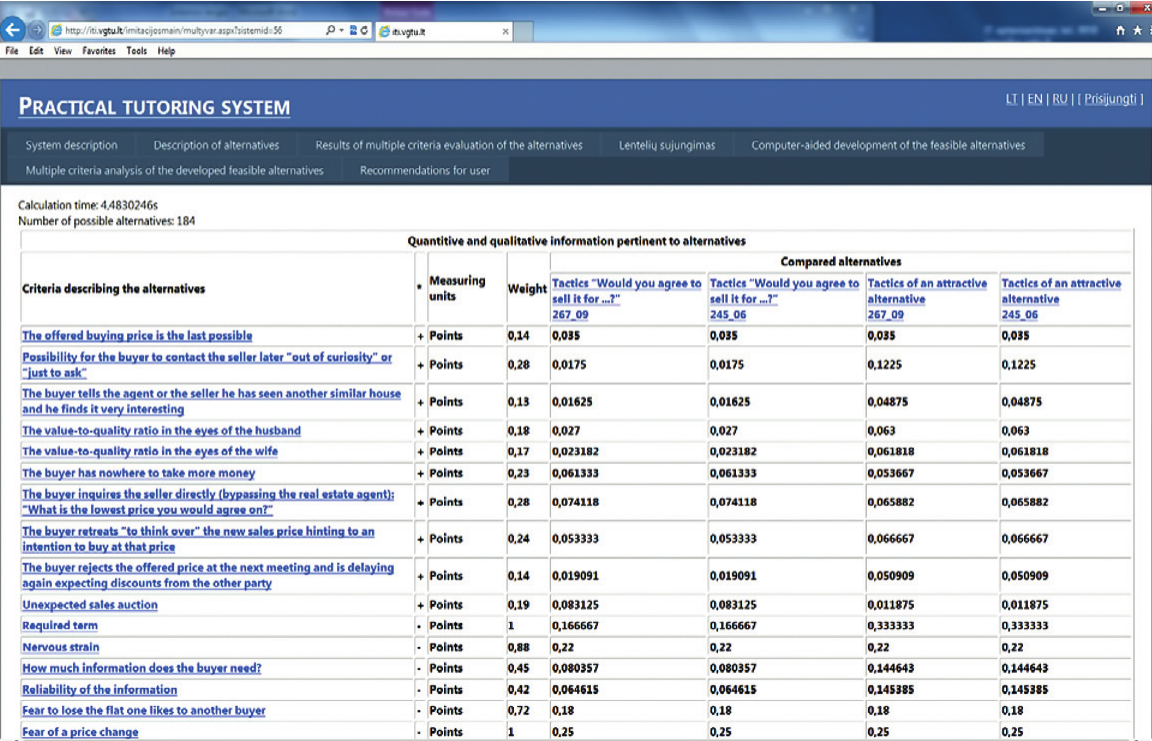
Fig. 8. Fragments of multiple criteria analysis of the feasible